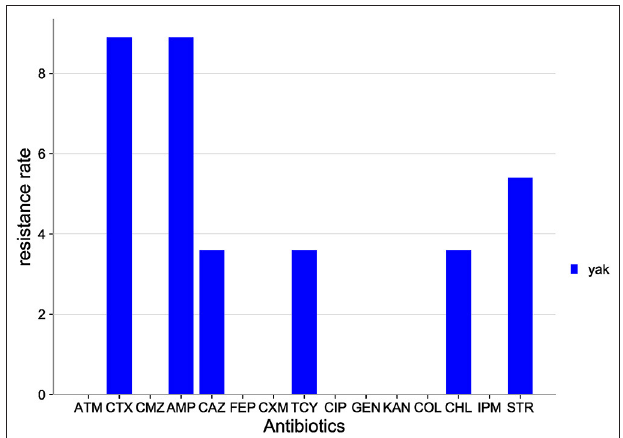
FIGURE 8 | Comparison of antibiotic resistance in E. coli from yaks in different